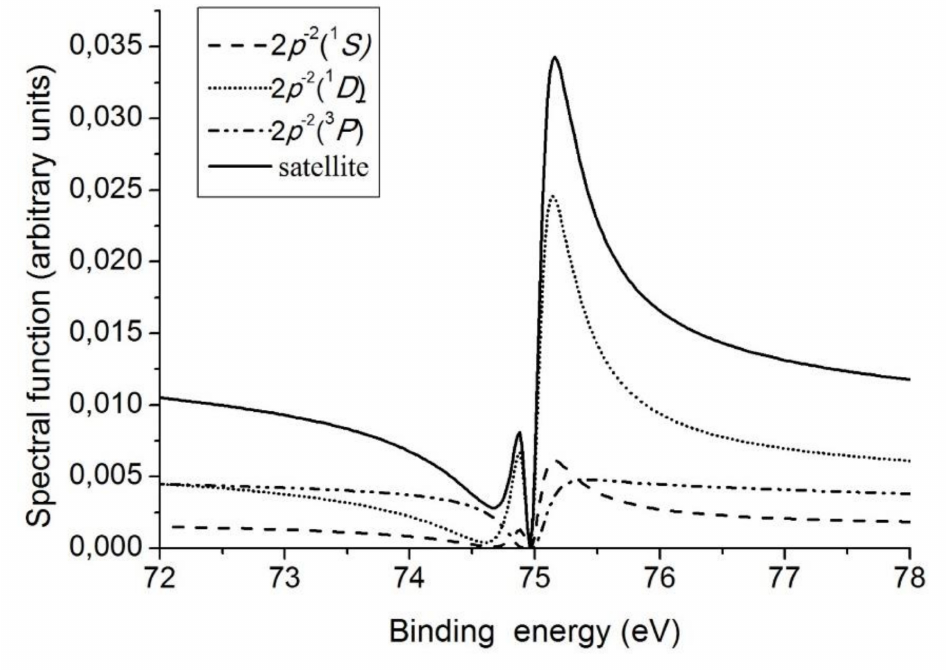
Figure 3. Theoretical lineshape of the satellite 2 s − 1 2 p − 1 ( 1 P ) 3 s ( 2 P ) which is broadened by the decay into three continua 2 p − 2 ( 3 P ) ε p ( 2 P ) , 2 p − 2 ( 1 D ) ε p ( 2 P ) and 2 p − 2 ( 1 S ) ε p ( 2 P ) (at the satellite energy